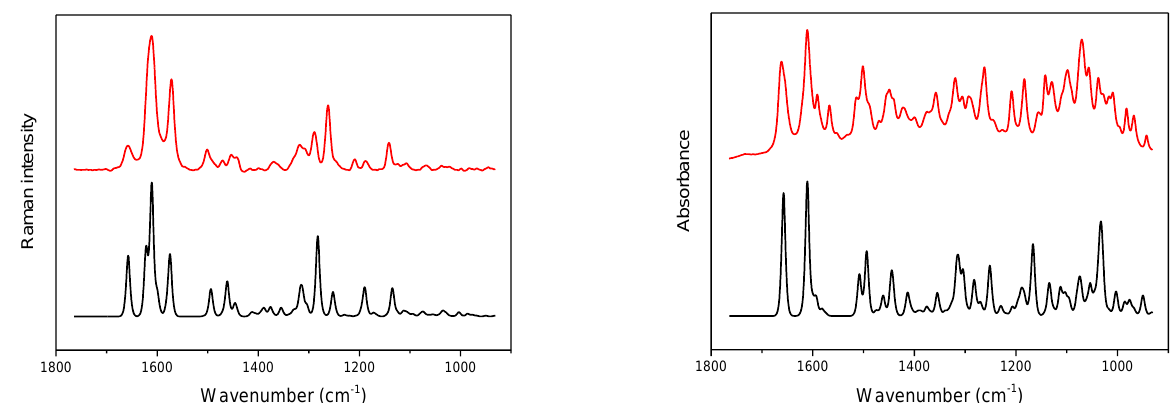
Figure 2. Experimental (red) and calculated (black) Raman ( left ) and IR ( right ) spectra of hydrated diosmin (DSNM); for calculated spectra abscissa scale multiplied by a factor of 0.98; Gauss-Lorentz profile with a half-width of 8.9 cm −1 was used to obtain calculated spectra.